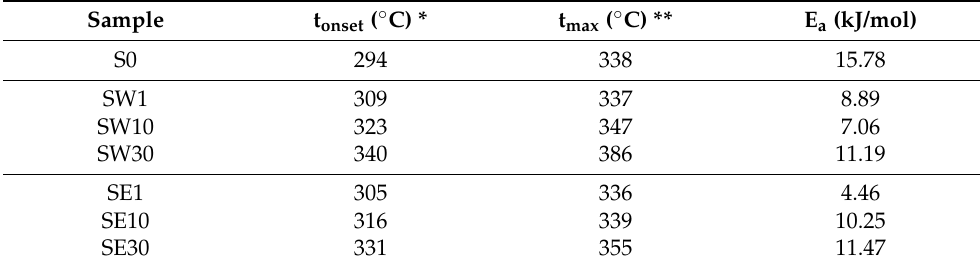
Table 2. Parameters resulted from thermogravimetric